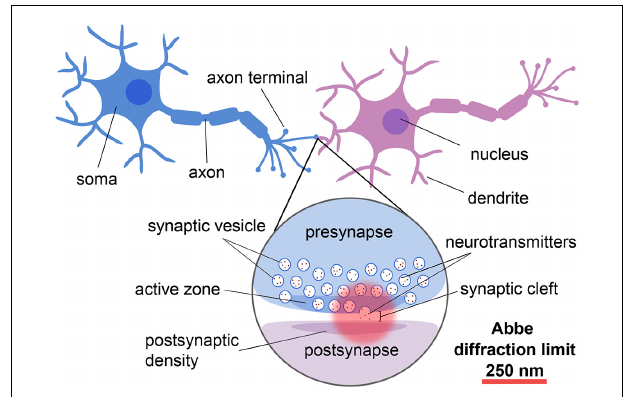
FIGURE 1 | Schematic showing the different components and length scales involved in neuronal and synaptic imaging demonstrating the importance of super-resolution techniques for resolving these